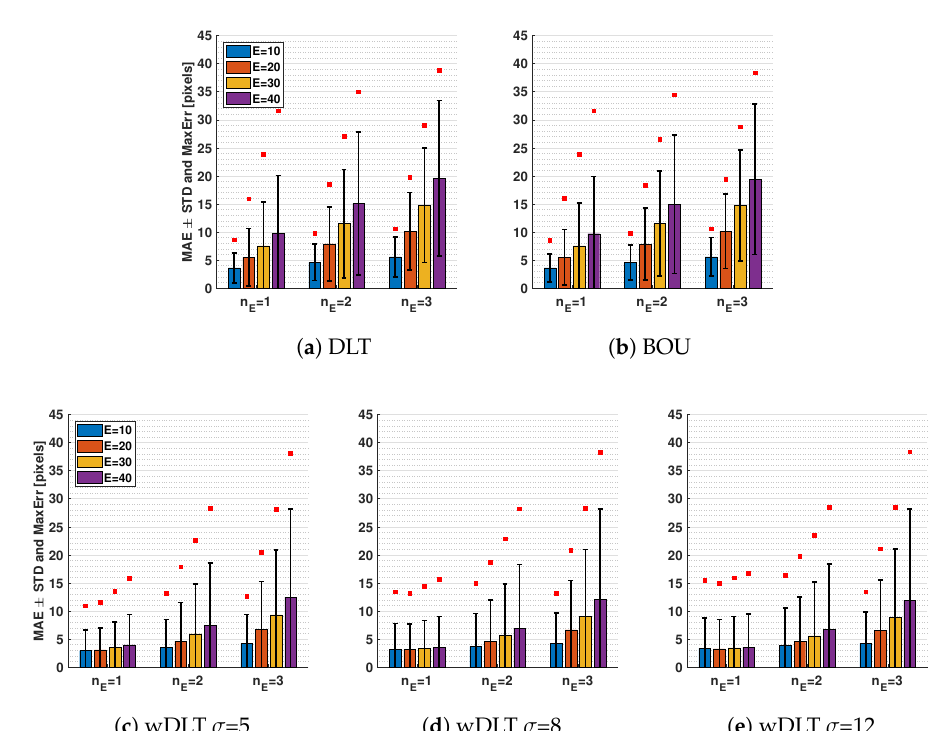
Figure 5. Reprojection error of the calibration with DLT, BOU, and wDLT with n E perturbed control points and error E; bars represent the mean absolute error (MAE), the black lines the average STD of the errors, and the red squares the average of the maximum